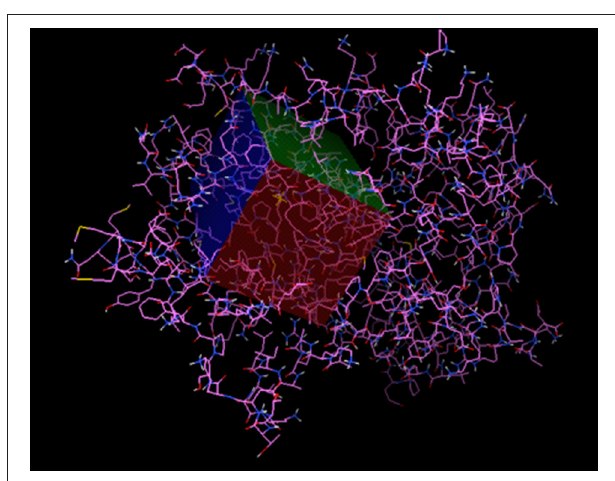
FIGURE 1 | The active region of PPAR γ